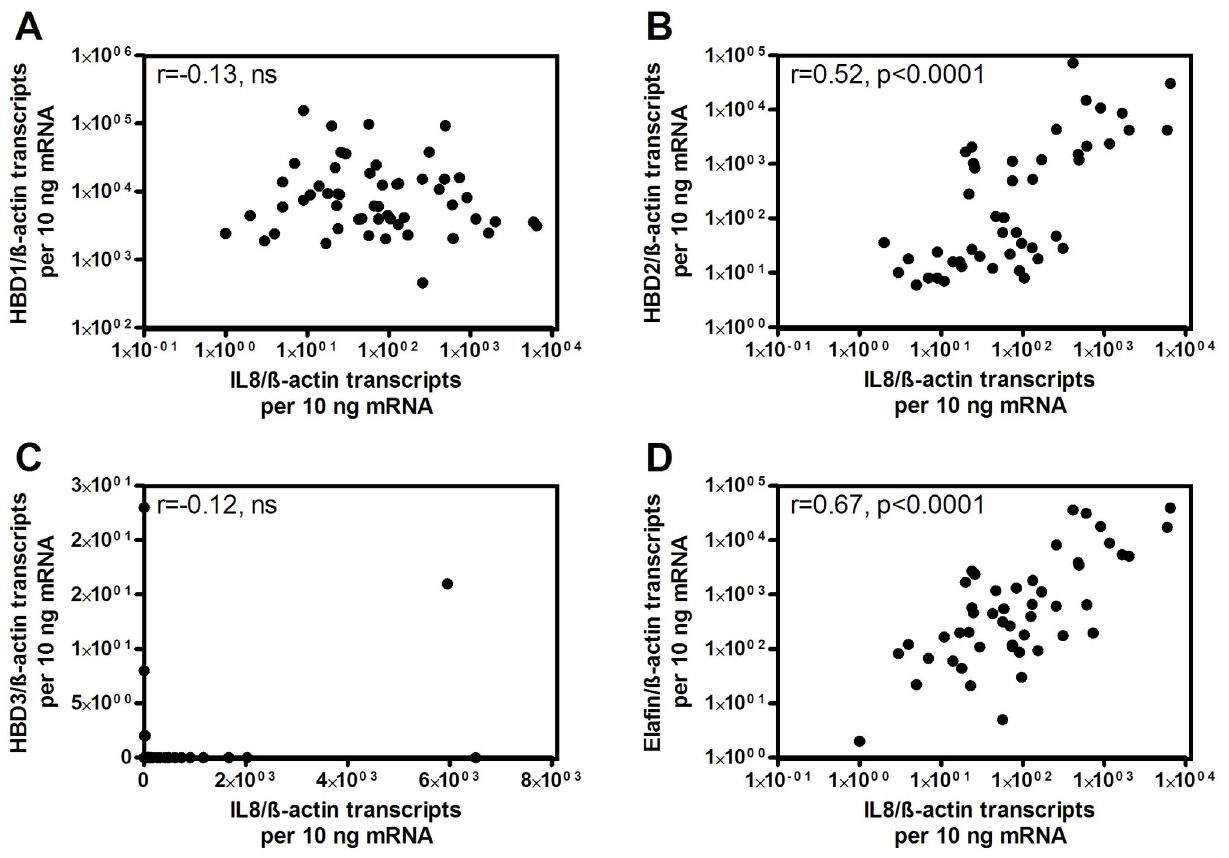
Figure 4. Correlation of IL8 with HBD1, HBD2, HBD3 and elafin. IL8 correlates significantly with HBD2 (B) and elafin (D), but not with HBD1 (A) and HBD3 (C, r = correlation coefficient, ***: